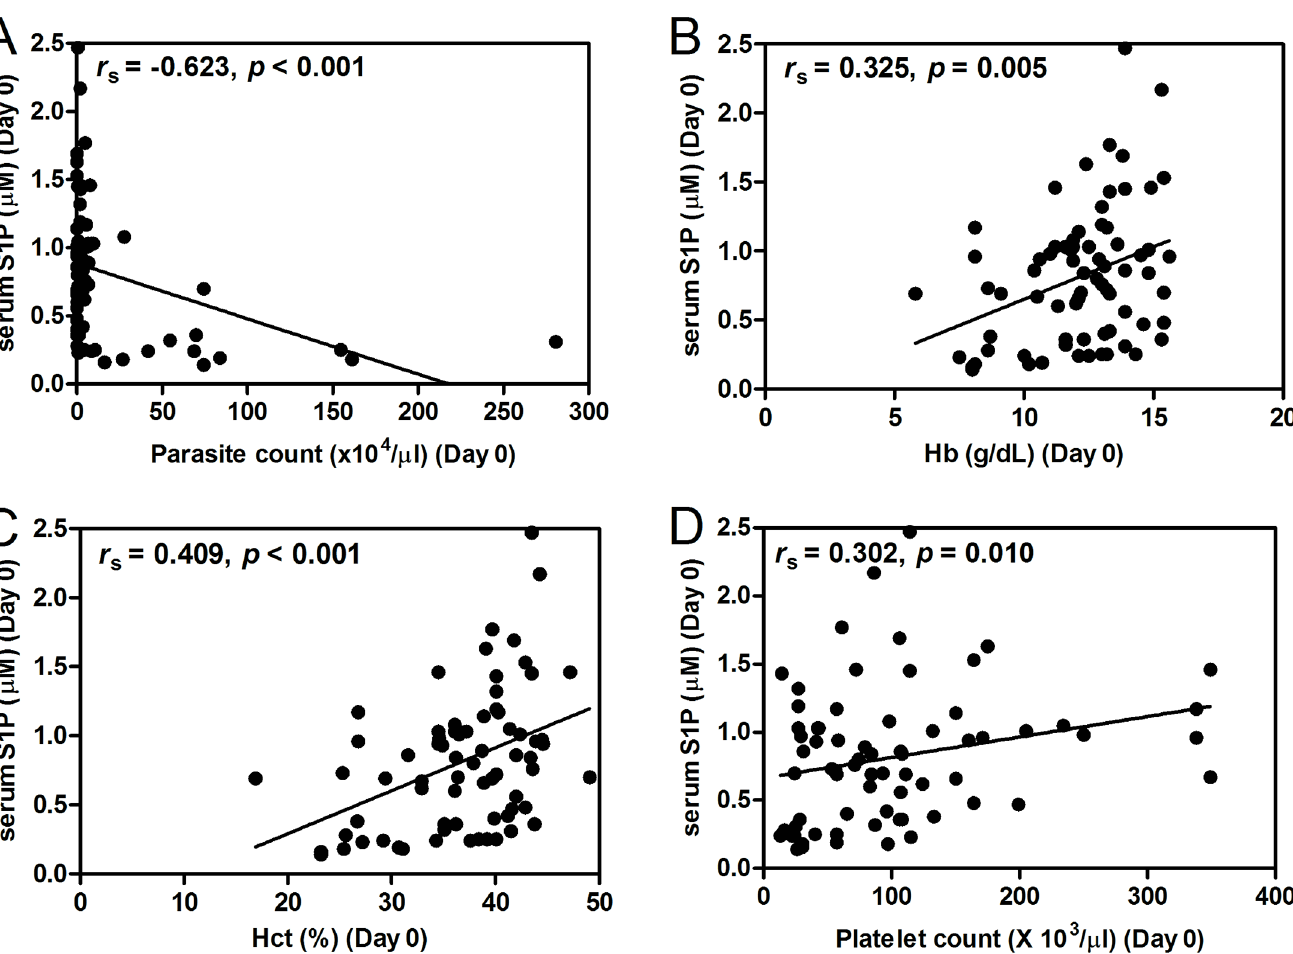
Fig 2. Correlations of serum S1P on admission with parasite count, hemoglobin (Hb), hematocrit (Hct), and platelet count in all malaria patients (n = 72). Data analyzedby Spearman’srank correlation.